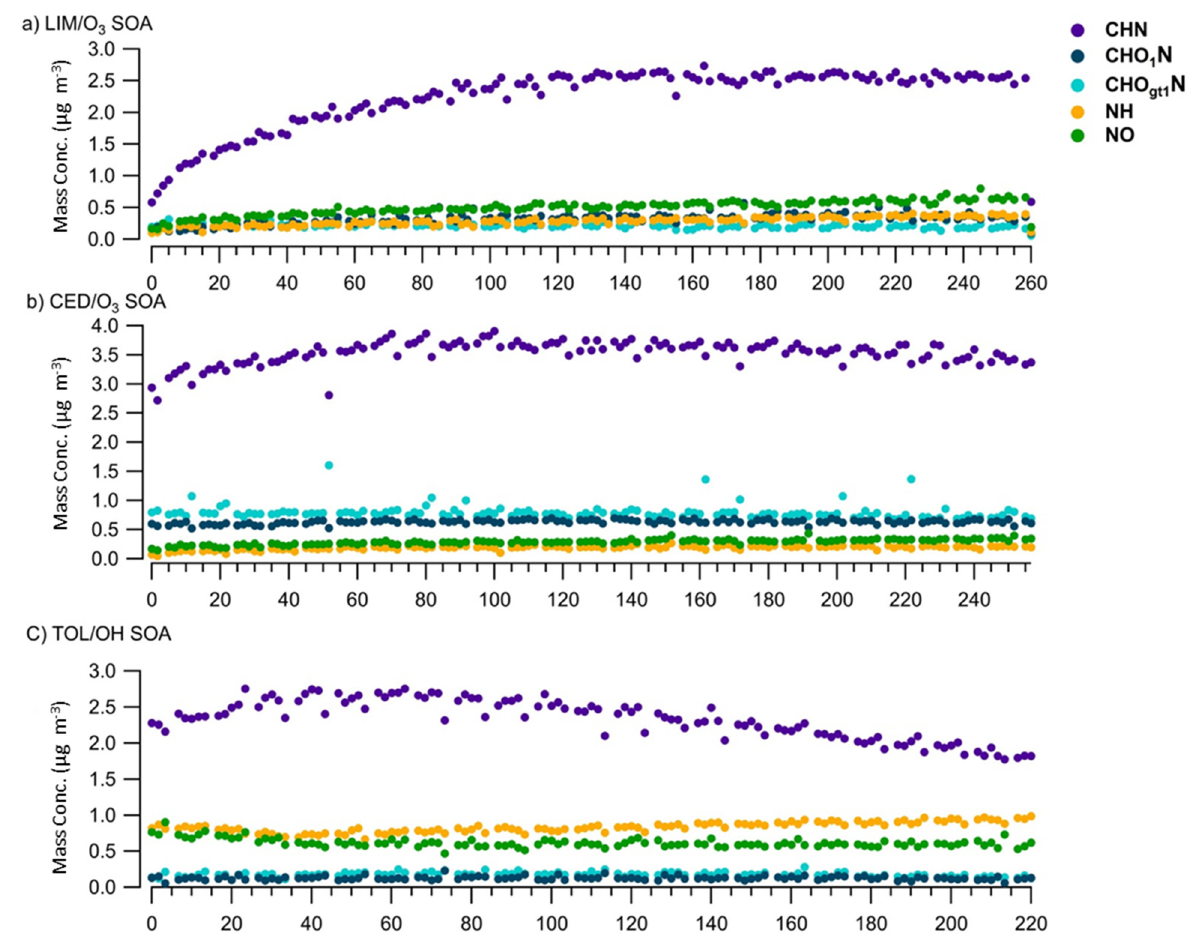
Figure 5. Mass concentration of nitrogen-containing families extracted from AMS data plotted versus time after DMA exposure for ( a ) LIM/O 3 SOA, ( b ) CED/O 3 SOA, ( c ) TOL/OH SOA under low RH.